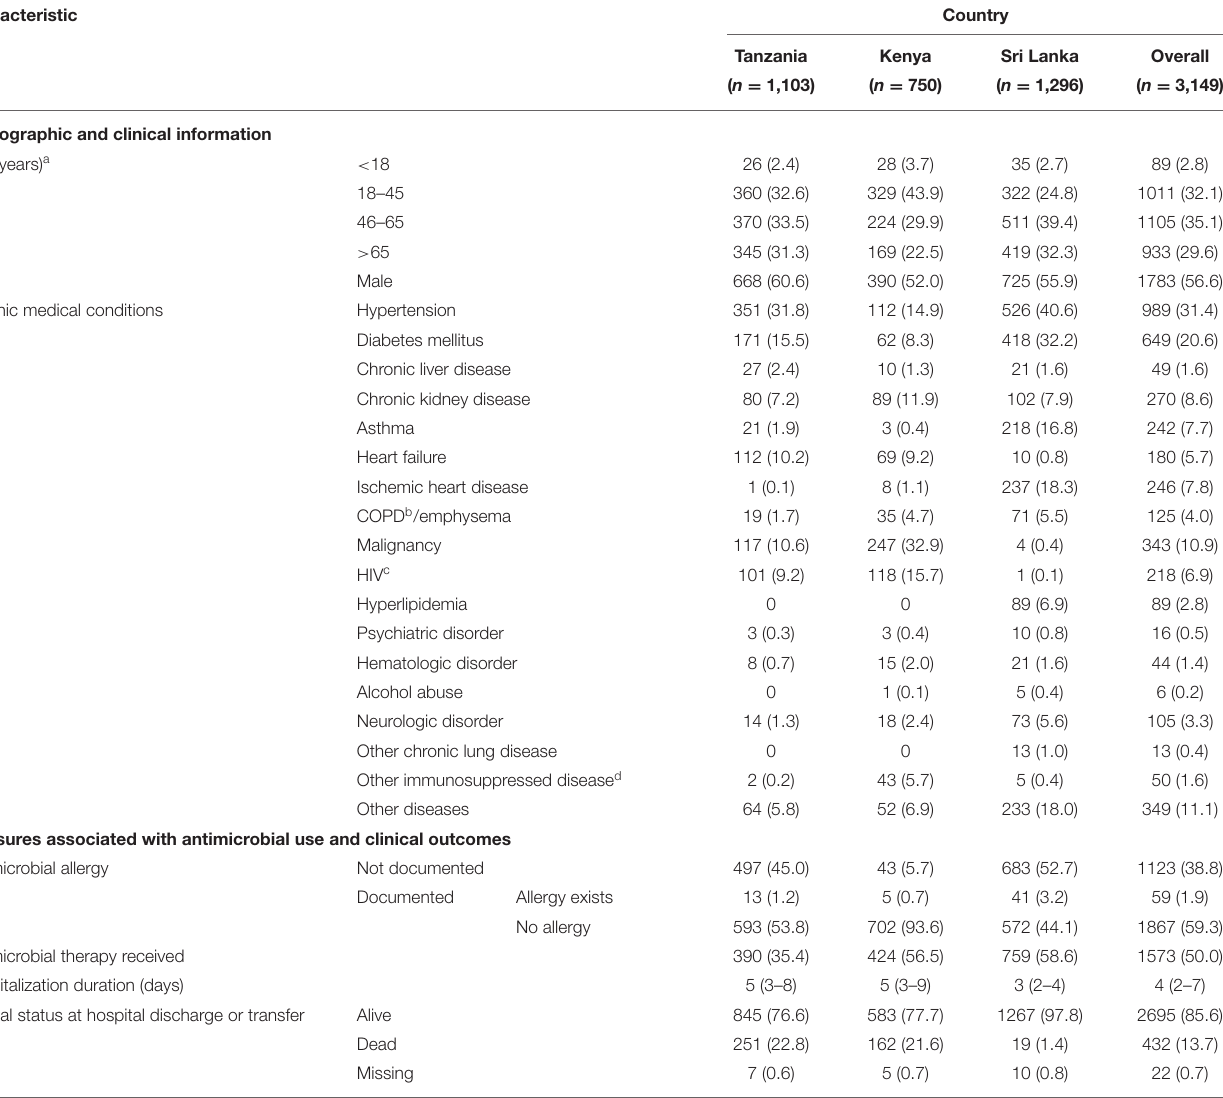
TABLE 1 | Demographic characteristics, site-specific antimicrobial use, and outcomes among patients at three tertiary care hospitals in Tanzania, Kenya, and Sri Lanka ( N = 3,149). Characteristic